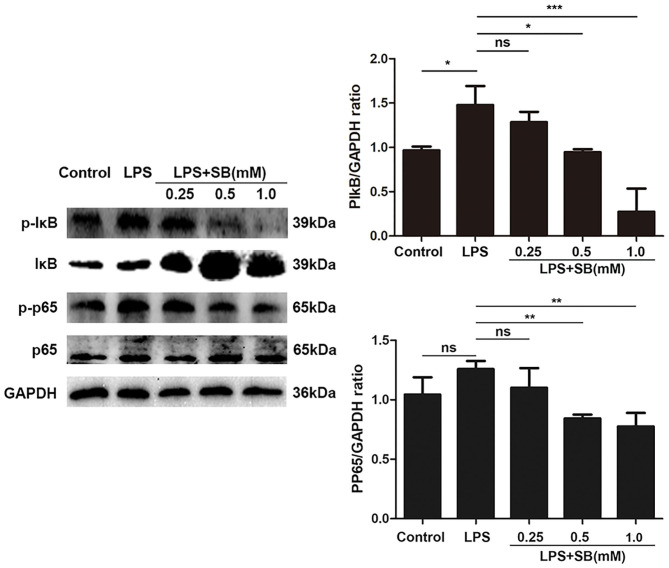
Sodium butyrate inhibited canonical NF-κB signaling pathway. Bovine macrophages were treated with different concentrations of sodium butyrate (0.25, 0.5, 1 mM) for 12 h, followed by stimulation with LPS for 3 h. Western blotting was performed to determine phosphorylation levels of IκB and p65. The quantification of band intensity was determined by densitometry and normalized to GAPDH. The values were shown as means ±SD (n = 3). nsp > 0.05 meant no significance, *p < 0.05, **p < 0.01, ***p < 0.001 compared to the LPS group.